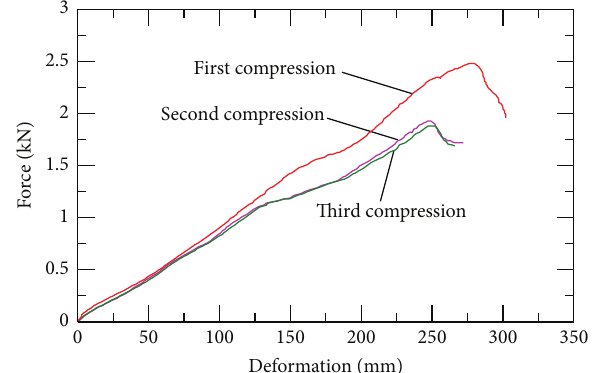
Figure 7: The force-deformation curve of tire under repeated radial compression.